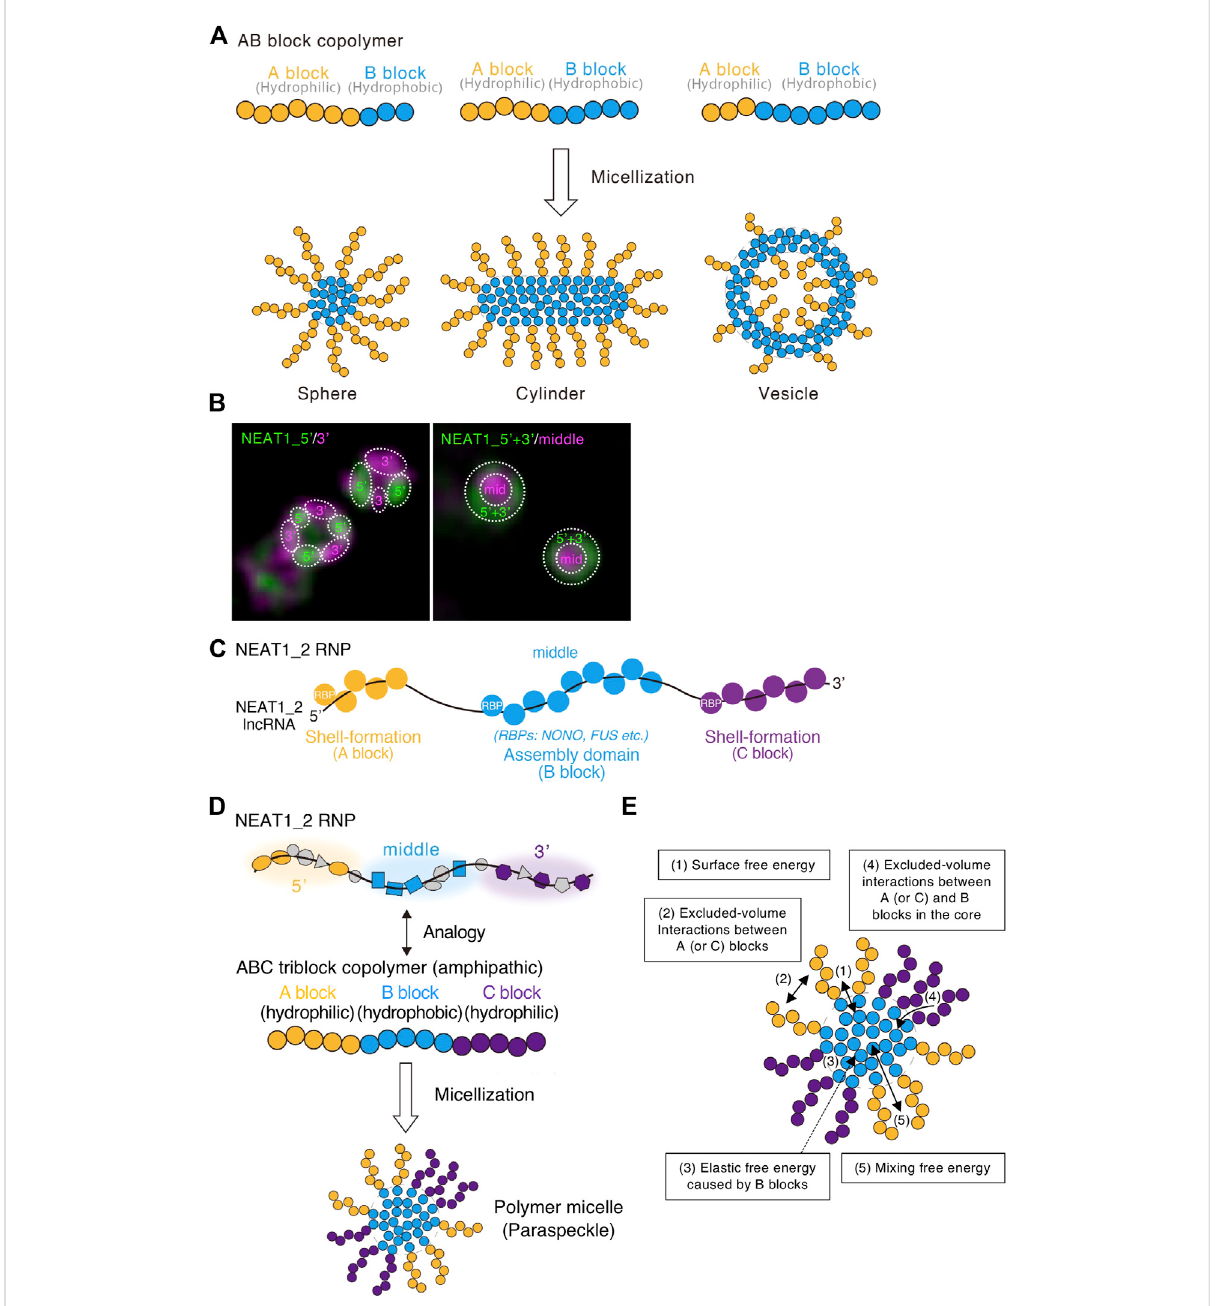
FIGURE 4 ABC triblock copolymer micelle model of the paraspeckle. (A) Schematics of AB amphipathic (di)block copolymers with different block lengths and themicellestheyform inwater. (B) The5 ′ and 3 ′ domains ofNEAT1_2localizeindistinct shelldomains oftheparaspeckle.The super-resolution images(structuredilluminationmicroscopy)withindicatedprobesareshown.Dottedcirclesindicatethedomainswithintheparaspeckleswherethe 5 ′ ,3 ′ ,and/ormiddledomainsofNEAT1_2localize. (C) RNA-bindingproteins(RBPs)coattheshell-formationdomainsandtheassemblydomain of the NEAT1_2 long non-coding RNA (lncRNA). (D) ABC triblock copolymer micelle model of the paraspeckle. (E) Energetic contributions (1 – 5) considered in the ABC triblock copolymer micelle model of the paraspeckle are shown in a